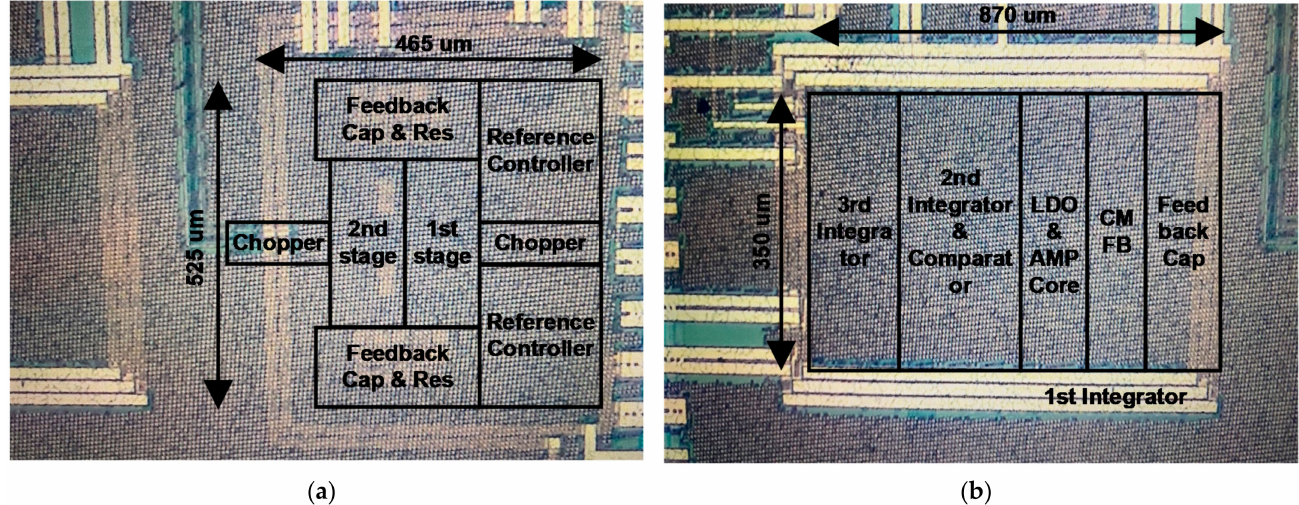
Figure 23. Die photograph of ROIC prototype fabricated in 0.18 um CMOS process: ( a ) TIA; ( b )